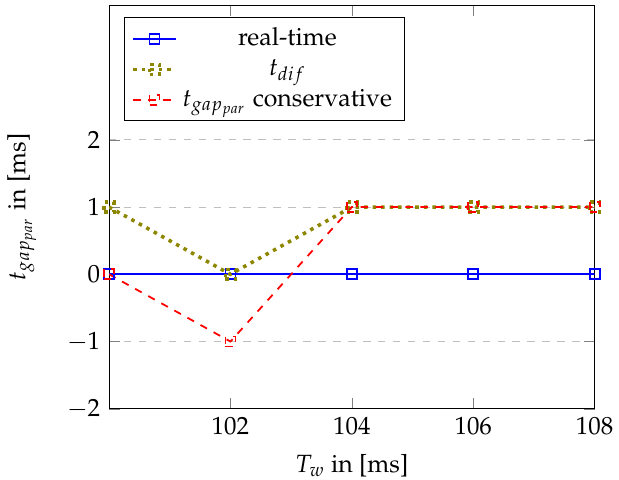
Figure 5. Typical scenario of a conservative synchronisation scheme using lookup window.